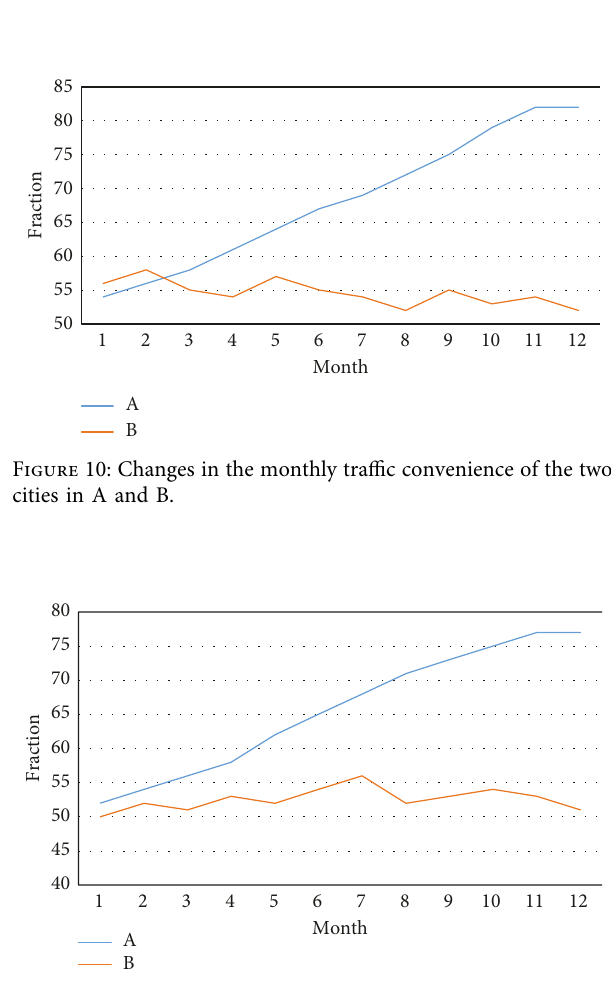
Figure 11: Changes in the monthly satisfaction of citizens in the two cities A and B.